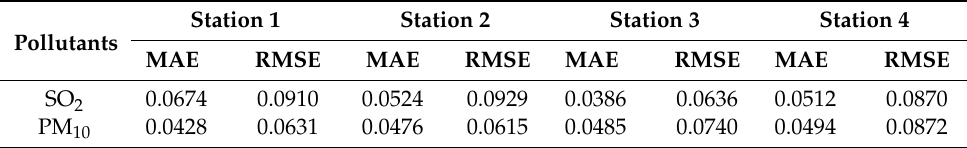
Table 8. Forecast accuracy of ANN of pollutants.